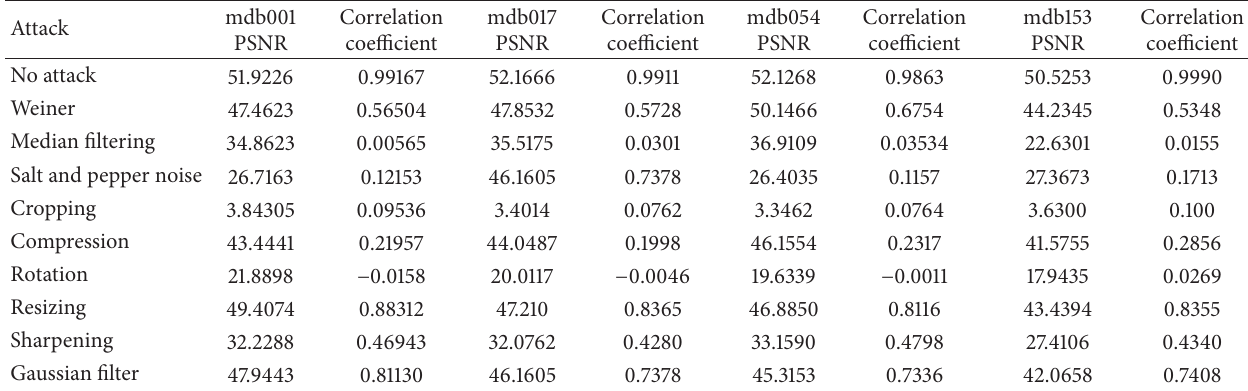
Table 2: Correlation coefficients of extracted watermarks ( 𝛽 = 1).